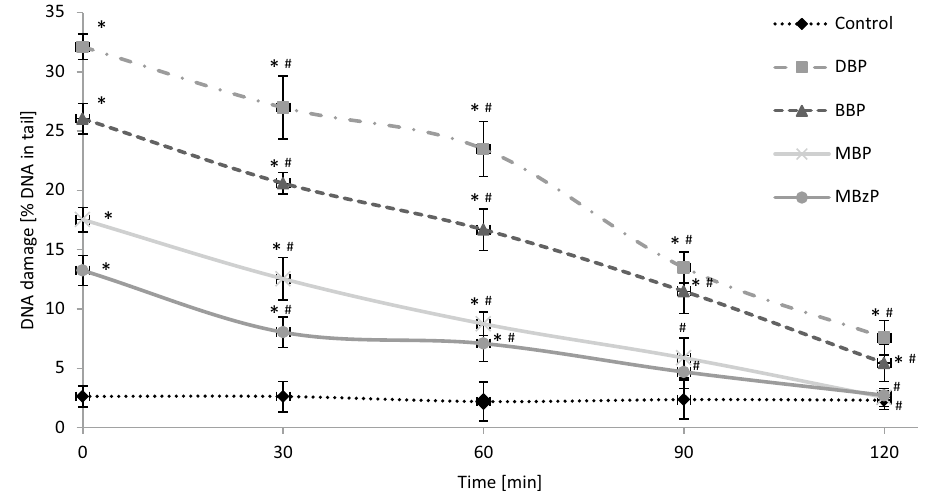
Figure 5. Time course of the repair kinetics of DNA damage (SSBs and DSBs), measured as DNA in comet tail derived from PBMCs treated for 24 h with DBP, BBP, MBP or MBzP in the concentration of 10 µg/mL, then for 2 h in medium deprived of these compounds. (*) Statistically significant different from control (p < 0.05). ( # ) Statistically significant different in comparison to time "0" for individual compound (p < 0.05). Each value represents the mean ± SD calculated from 5 individual experiments (5 blood